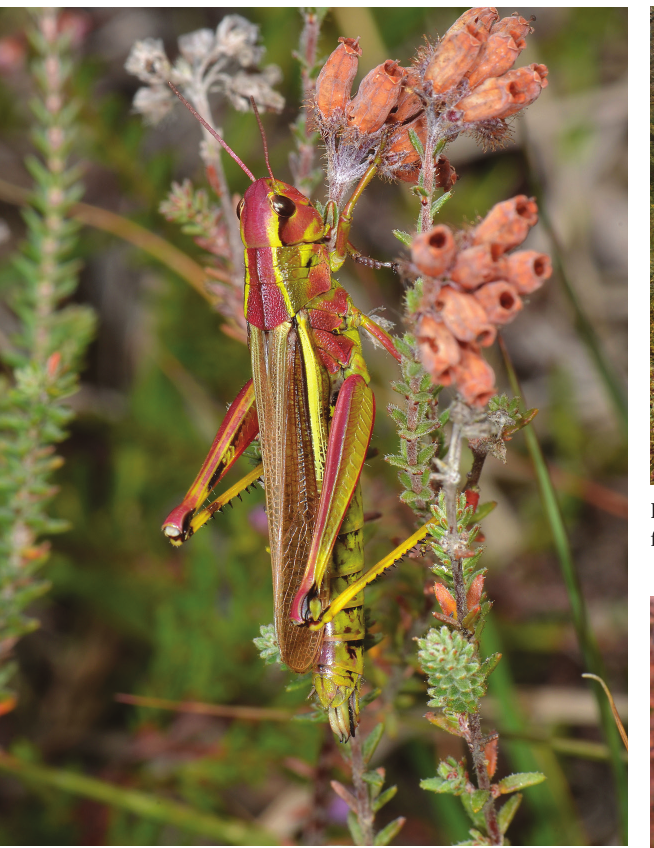
Fig. 1. Female Stethophyma grossum purple form; credit P. Brock.